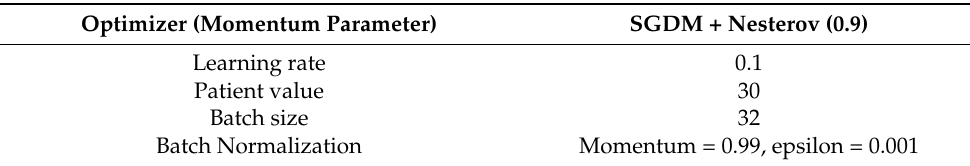
Table 3. Hyper-parameter configuration of the network.